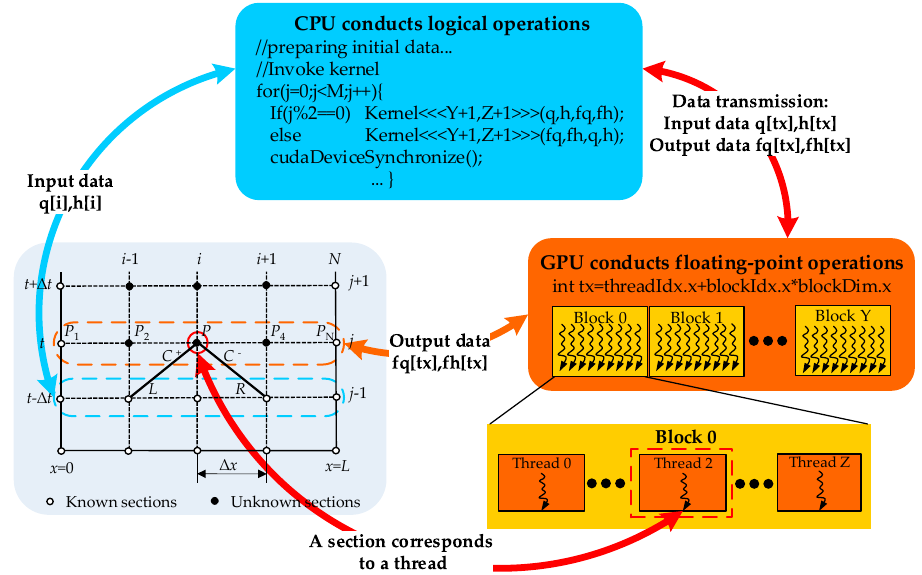
Figure 1. Schematic of parallel strategy of the GPU-MOC method: CPU codes dispose logical operations, the Cartesian mesh in the x-t plane for MOC, and the thread organization structure of the GPU.